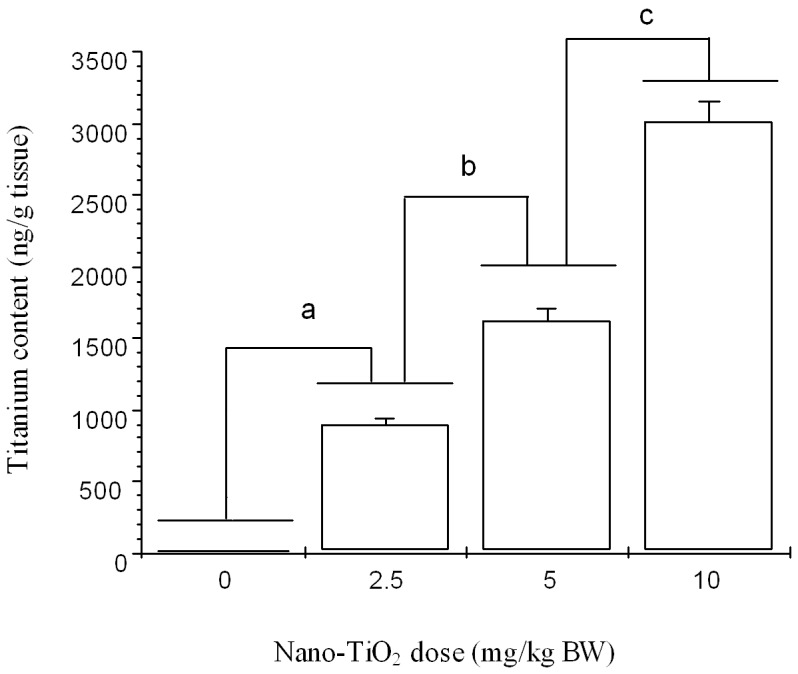
Titanium accumulation in mouse ovary caused by intragastric administration of nano-TiO2 for 90 consecutive days.Different letters indicate significant differences between groups (p<0.05). Values represent means ± SE (N = 5).